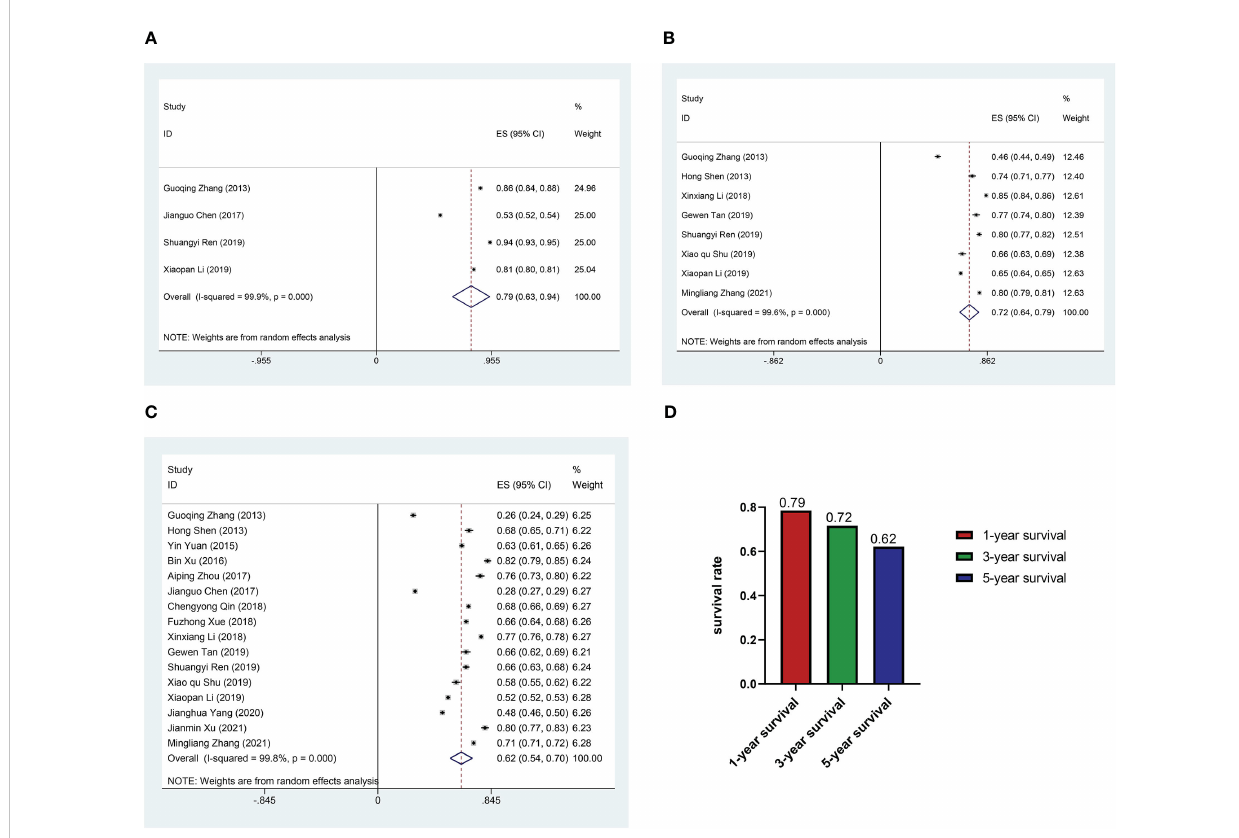
FIGURE 2 Pooled survival rate. (A) Forest plot of pooled 1-year survival rate in patients with colorectal cancer. (B) Forest plot of pooled 3-year survival rate in patients with colorectal cancer. (C) Forest plot of pooled 5-year survival rate in patients with colorectal cancer. (D) Histogram of pooled 1, 3, 5-year survival rate in patients with colorectal